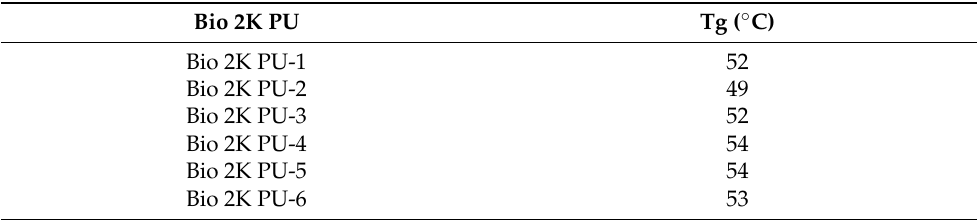
Table 8. Tg of the different bio-based 2K